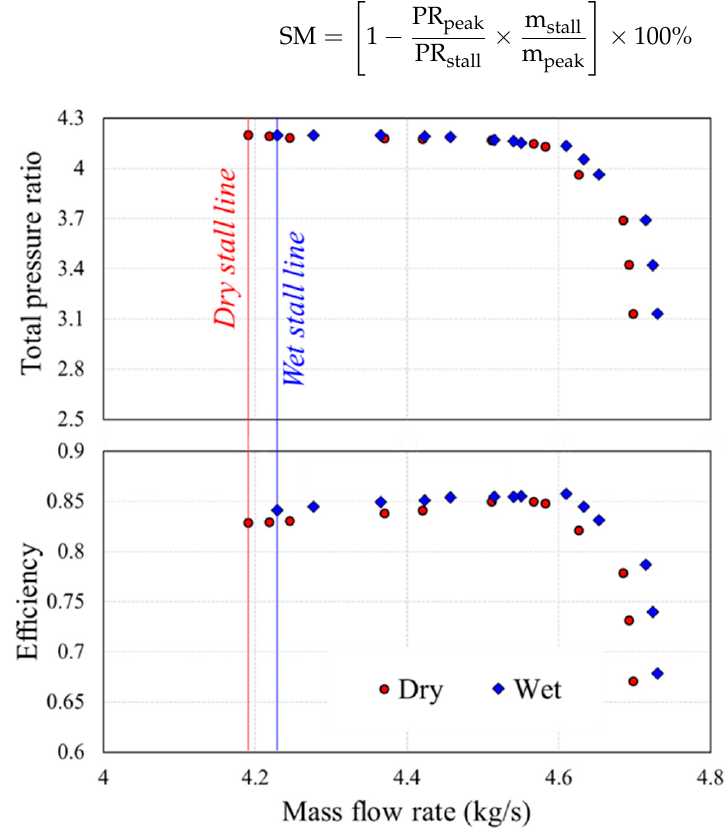
Figure 14. Comparison results of the performance curve between the dry and wet compression. The SM value decreased by 2% in the wet compression compared to the dry compres- sion. In general, the surge phenomenon occurs at a low flow rate point and occurs in the impeller and diffuser regions, causing an instability in the flow. Accordingly, the droplet motion changes the flow inside the impeller to reduce SM. Figure 15 shows the leakage flow occurring at the top of the tip clearance (red arrow) near the surge point. In the case of (a) dry compression, a few parts of the leakage flow generated from the top of the shroud went to the adjacent blade, but in the case of (b) wet compression, it can be noted that a large amount of the leakage flow generated from the top moved to the adjacent blade and formed a blockage (red circle). As a result, in wet compression, there is relatively more leakage flow that does not flow downstream and is